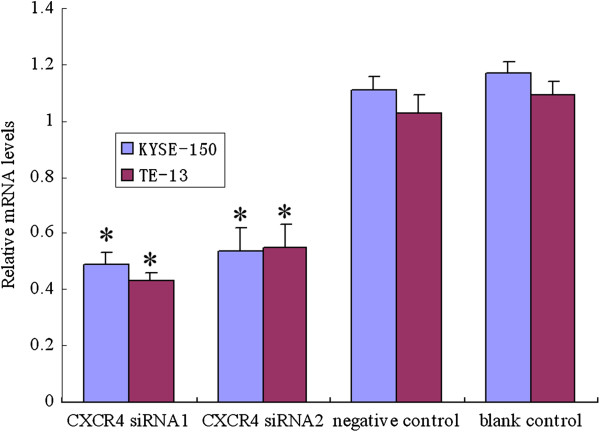
CXCR4 siRNA inhibited significantly the mRNA expression of CXCR4. Cells were incubated with different synthetic oligonucleotides as described in the materials and methods section, and CXCR4 mRNA was quantified by real time PCR. The targeted CXCR4 siRNA inhibited significantly the expression of CXCR4 gene (*p <0.05).